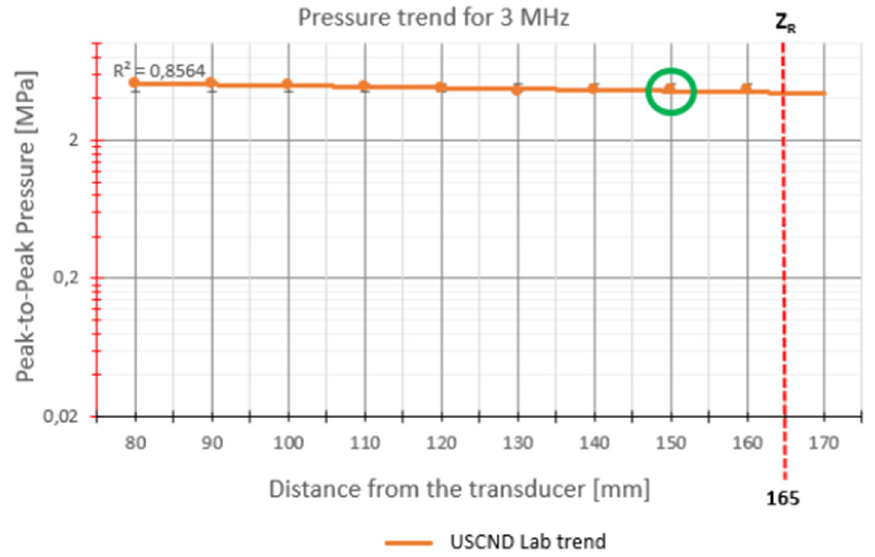
8 of 15 Figure 5. Focal distance calculation. At 2 MHz stimulation frequency the selected stimulation point is at a distance of 120 mm from the transducer (green circumference). This value results from the test made with the hydrophone and by a subsequent linear interpolation. Z R indicates the distance of Rayleigh (dotted line in red), in this case the Z R is located right after the cut-off region where the pression is very uneven. The orange line in the figure indicates the peak-to-peak pressure trend